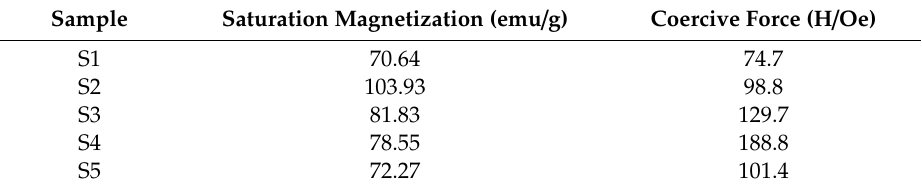
Figure 3. Magnetic hysteresis loop of Fe 3 O 4 hollow spheres at room temperature. Table 2. Magnetic properties of Fe 3 O 4 hollow spheres at different reaction time.